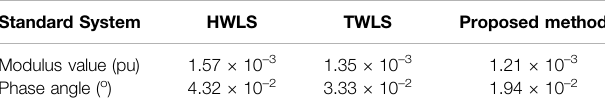
TABLE 3 | Average absolute error of voltage under Gaussian noise in three methods.